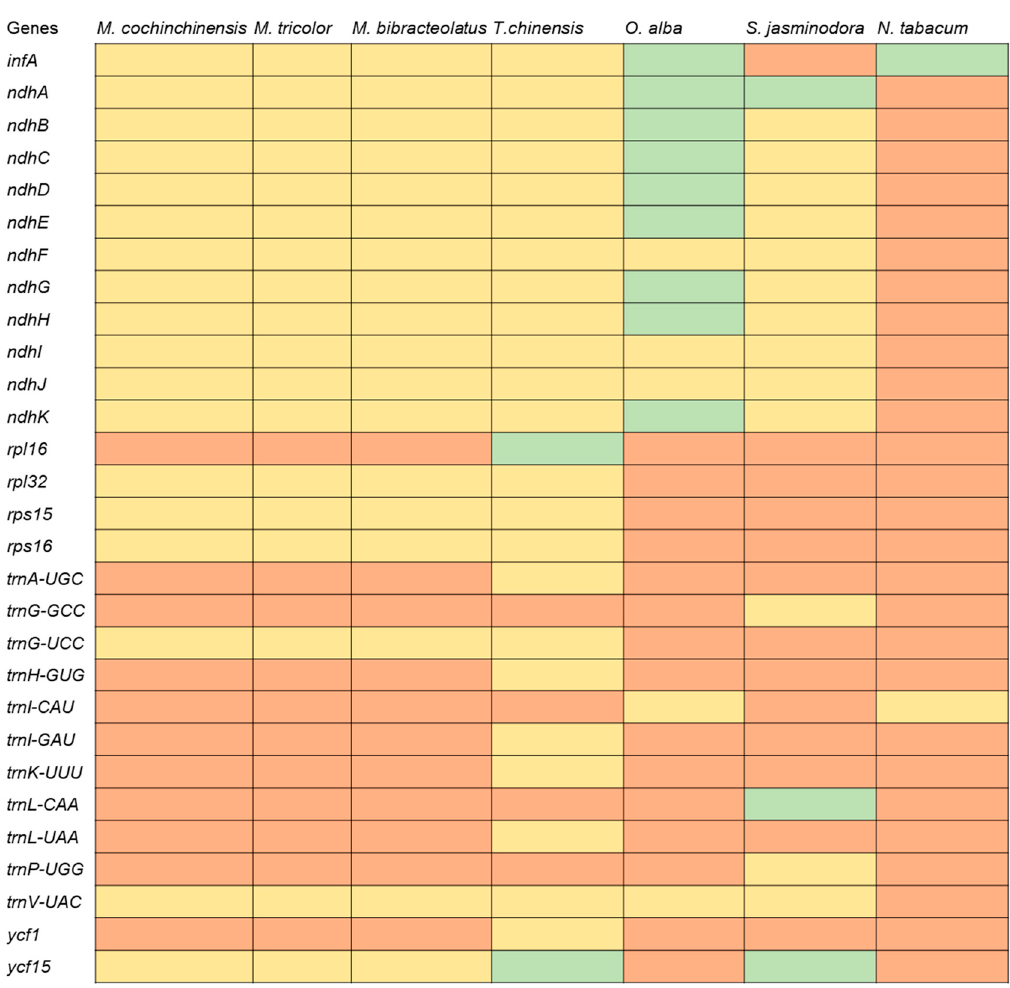
Figure 9. Comparison of the chloroplast genome gene content of six parasitic plants and one model plant ( Nicotiana tabacum ). The common existing genes in the complete chloroplast genome of the seven species are not listed. Red boxes indicate each gene present, and green boxes indicate that each gene is considered as a pseudogene. The yellow boxes indicate an absent gene.